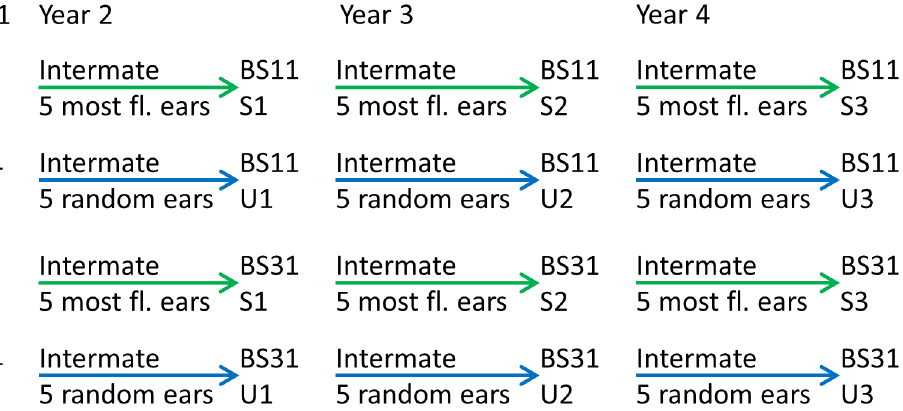
Fig 1. Breeding strategy used to develop selected and unselected populations over three generations. For the selected populations, the most fluorescent ears were the parents for the next generation. For the unselected populations, random ears were the parents for the next generation. The abbreviation fl. is for